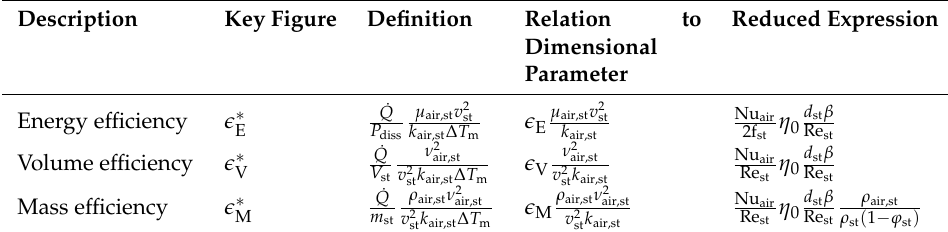
Table 3. Non-dimensional key figures for extended performance